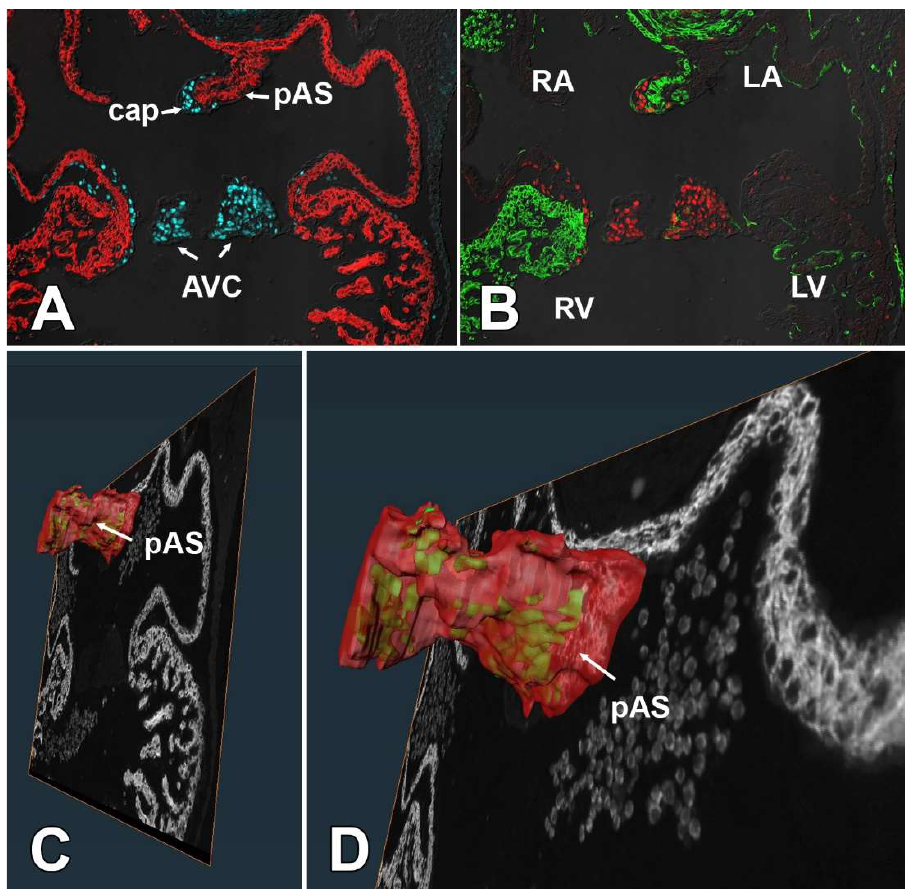
Figure 13. The SHF significantly contributes to the myocardial core of the primary atrial septum. Serial sections of a ED11.5 control heart were stained for Sox9 (blue in ( A) and red in ( B )), Myosin Heavy Chain (red in ( A )) and GFP (green in ( B )). A 3D rendering of the stained sections was generated in AMIRA software to demonstrate the distribution of the GFP stained SHF-derived cells (green in ( C , D )) within the myocardial core of the primary atrial septum (red in ( C , D )). AVC = atrioventricular cushion, cap = mesenchymal cap, pAS = primary atrial septum, LA = left atrium, LV = left ventricle, RA = right atrium, RV = right ventricle,.